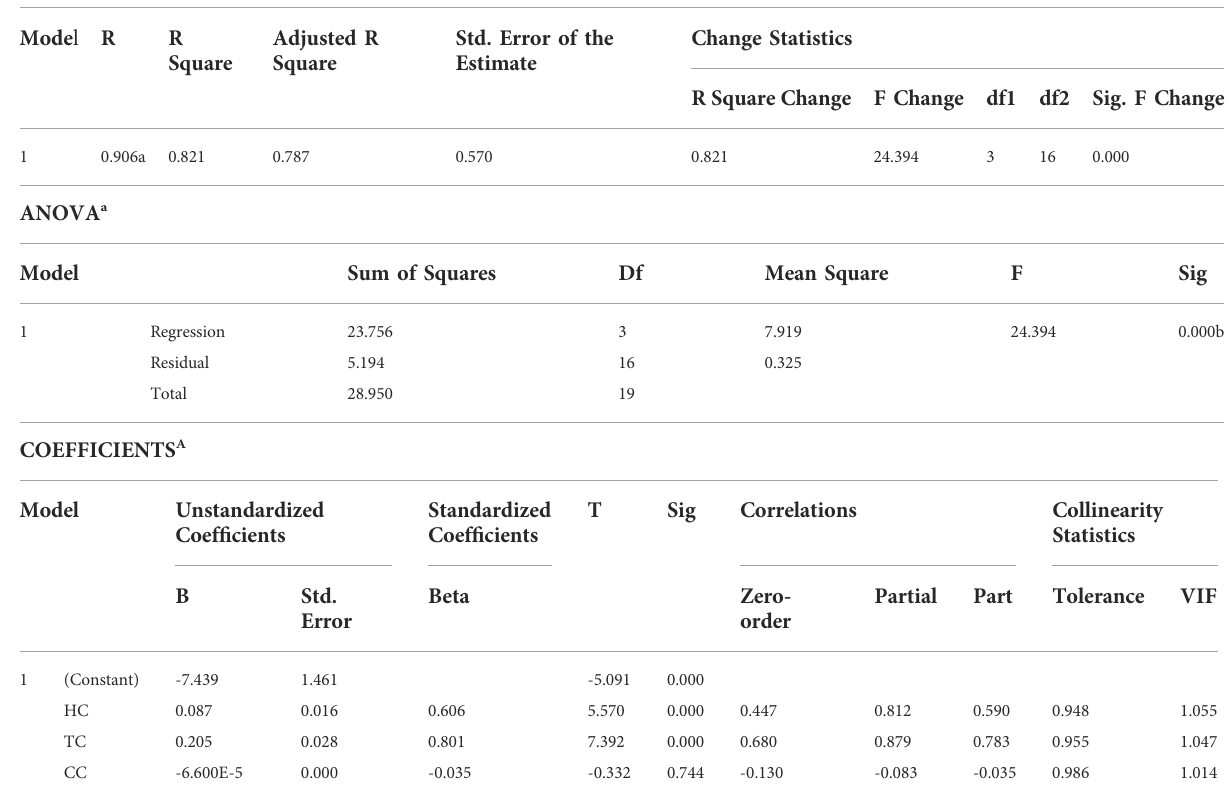
TABLE 8 Model summary, ANOVA, and coef fi cients of body fatigue. Model